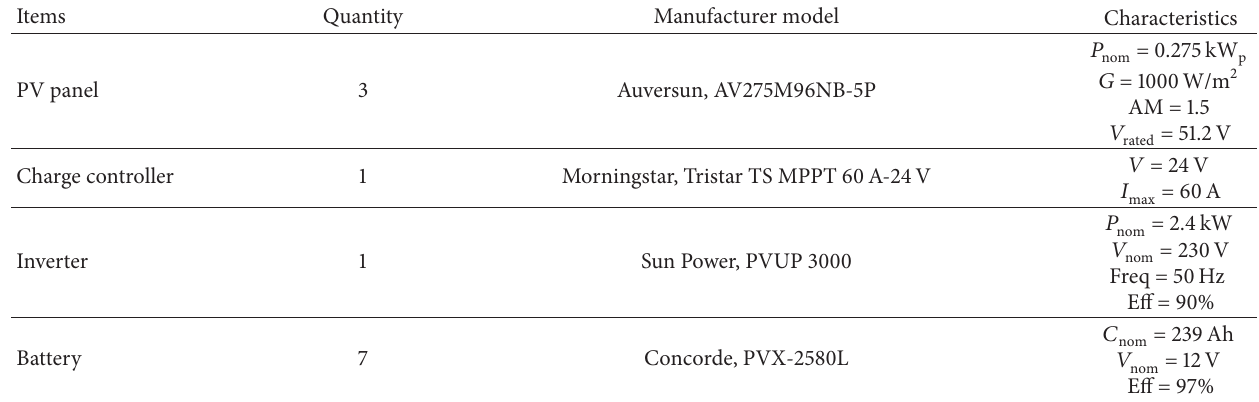
Table 2: Solar PV system components.